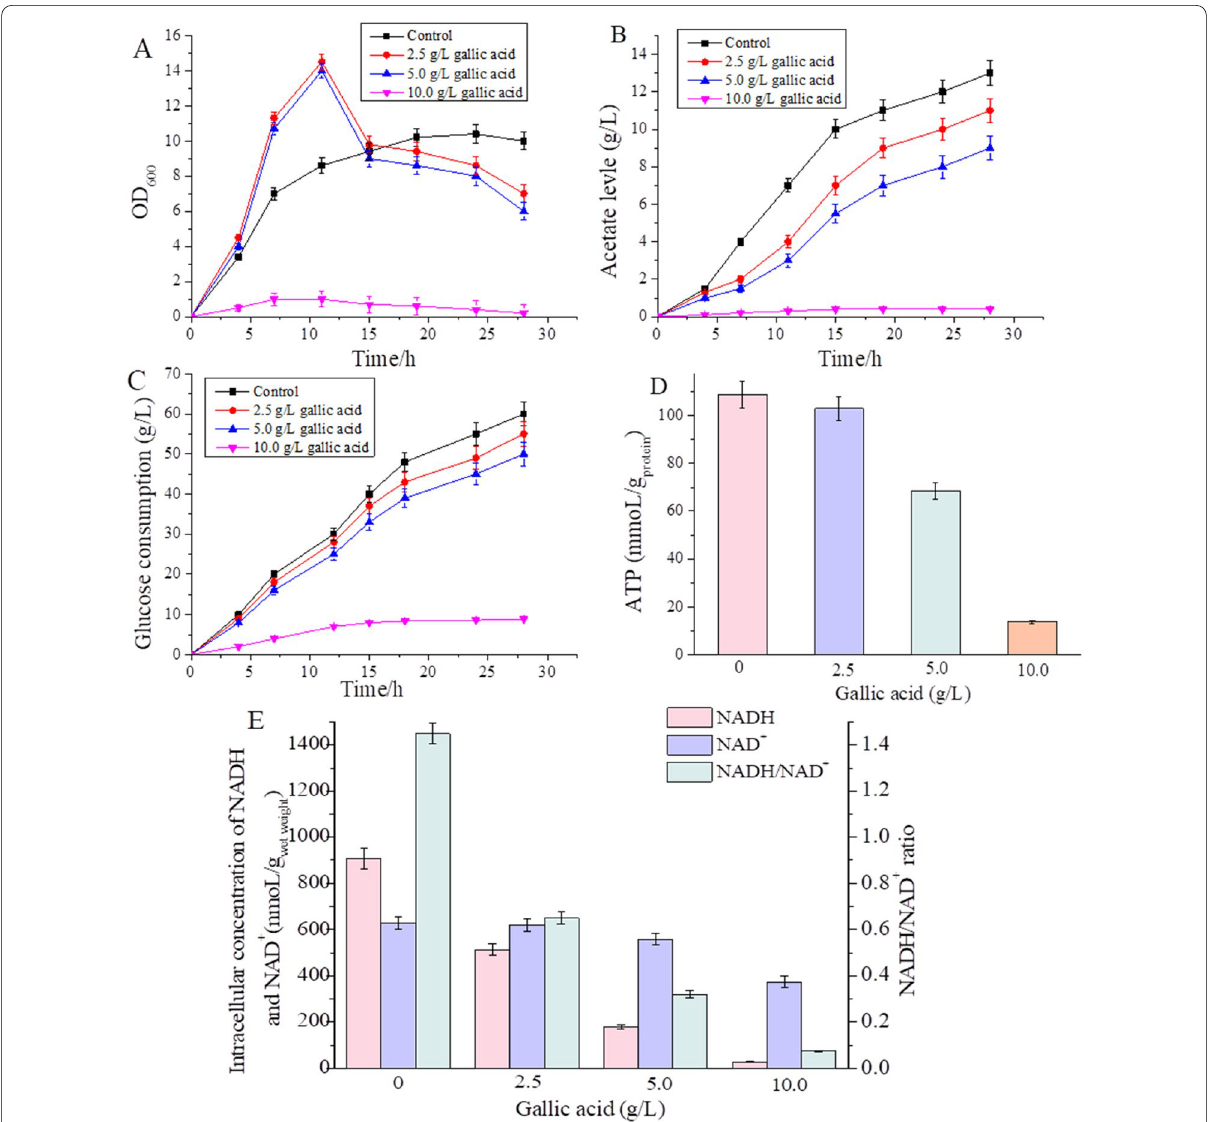
Fig. 2 Shaking flask fermentation of E. coli under different concentrations of gallic acid stress. A Biomass; B acetate level; C glucose consumption; D ATP content; E intracellular concentration of NADH, NAD + at 20 h, and the ratio of NADH/ NAD